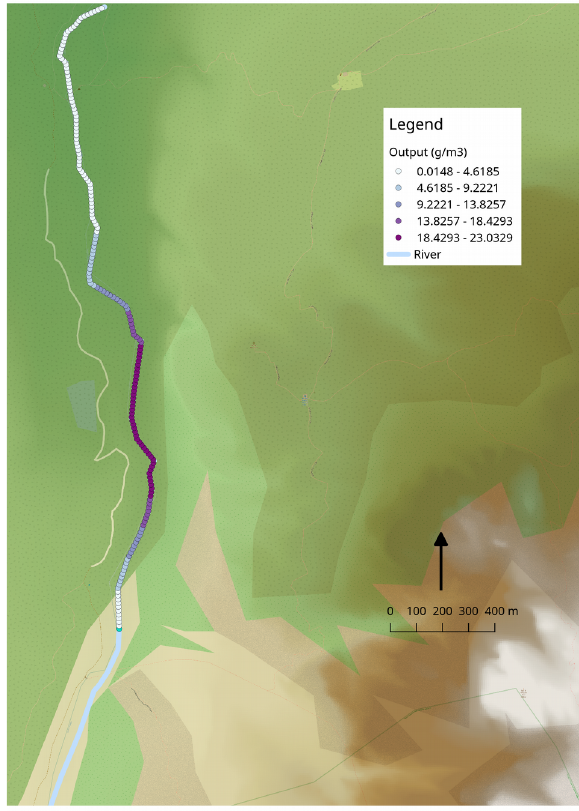
Figure 5. Example of output from the river module. Concentration of benzene 10 minutes after the release of 20000 grams in the point represented in